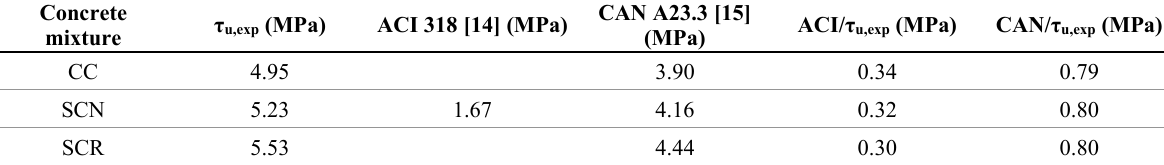
Table 7. Ultimate shear strength – experimental results and code